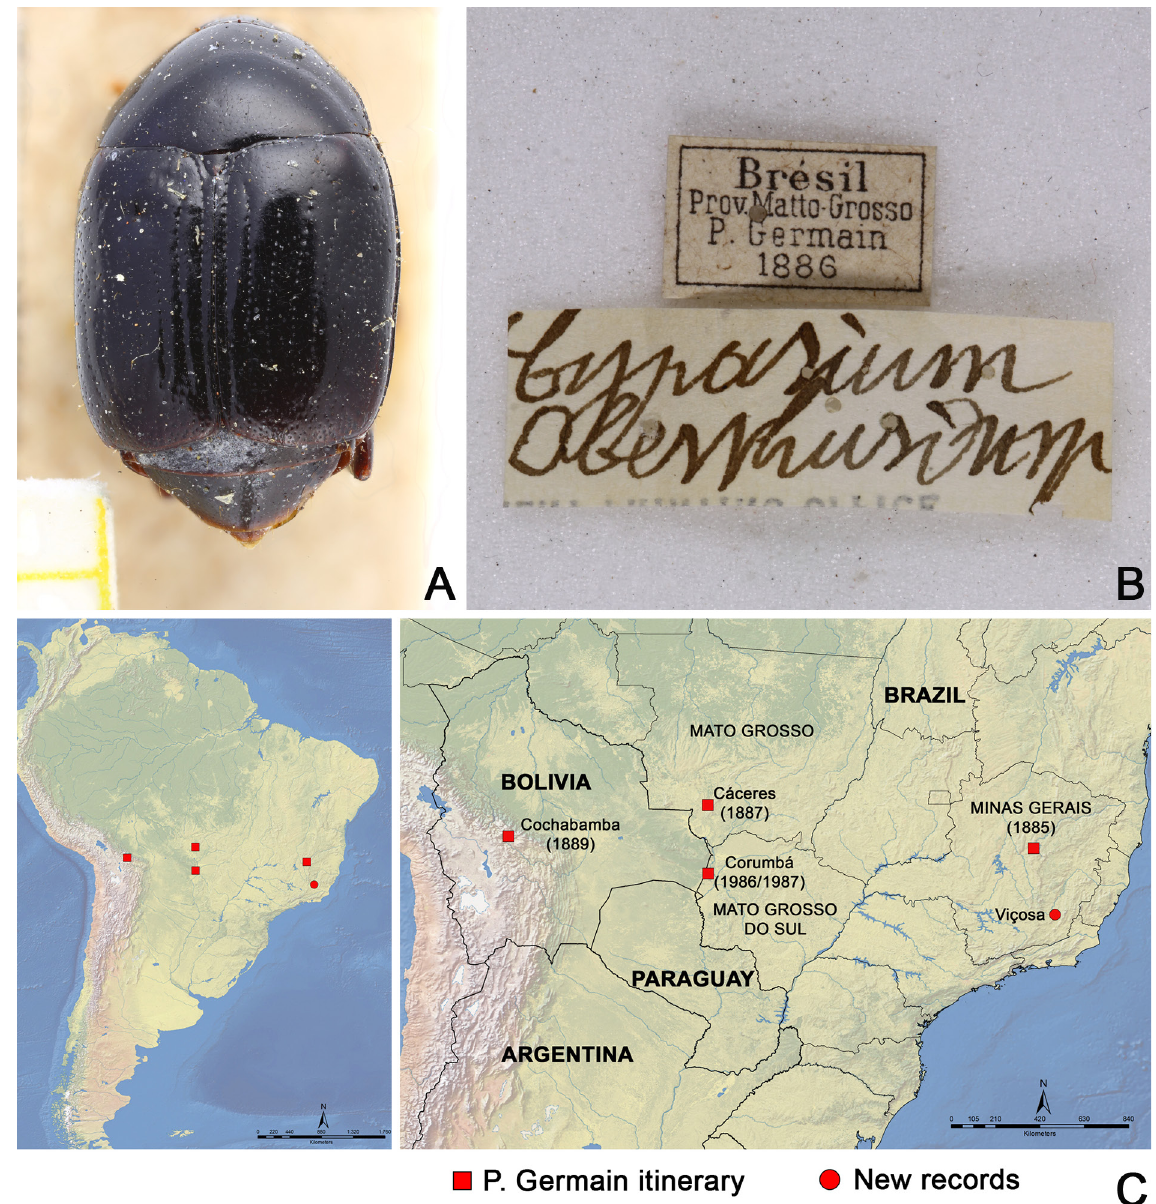
Fig. 64. Cyparium oberthueri Pic, 1956 (MNHN collection-Paris). A . Habitus. B . Labels. C . Distribution. Squares = P. Germain itinerary; circles = new